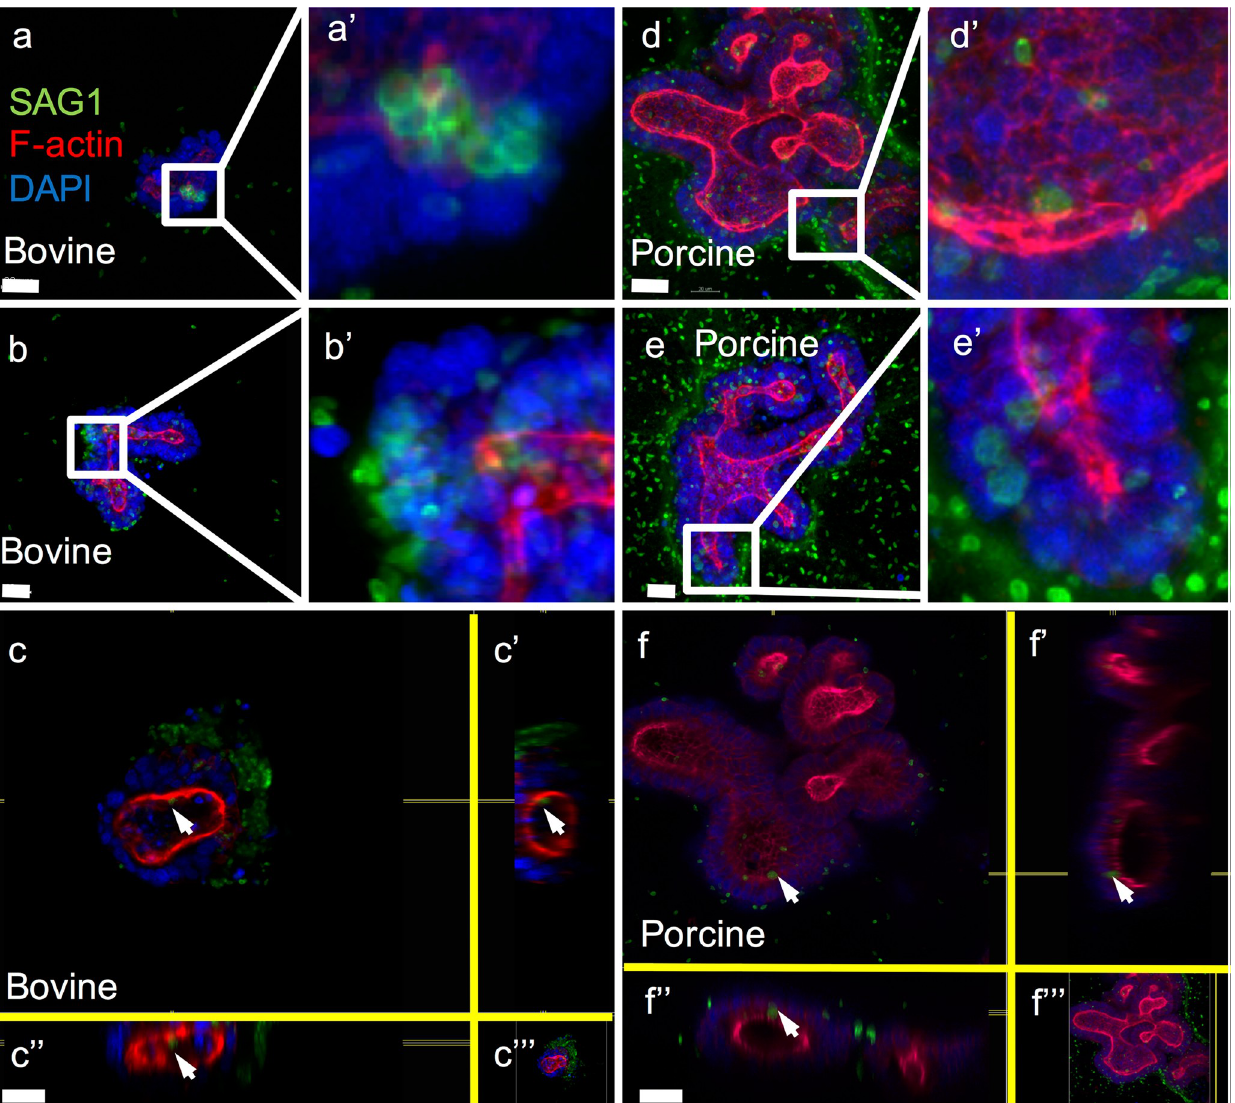
Fig 1. Schematic illustration of organoids using parasite surface antigen SAG1. Schematic illustration showing immunofluorescent staining of bovine (a–c) and porcine (d–f) intestinal organoids using parasite surface antigen SAG1 (Alexa Fluor 488—green), F-actin (rhodamine—red), and nuclei (DAPI— blue). Organoids were incubated with 10 6 T . gondii RH strain tachyzoites for 1 hour at 37˚C, embedded in Matrigel and incubated for a further 24 hours at 37˚C. SAG1 in green shows intraluminal parasites (a, d, a’, and d’), parasite rosettes indicating replication (b, e, b’, and e’), and white arrows point to intracellular parasites (c, c’, c”, f, f’, and f”). Scale bars represent 20 μ m in panels a, b, d, and e and 30 μ m in panels c and f. 400x magnification. Open-access image reused from